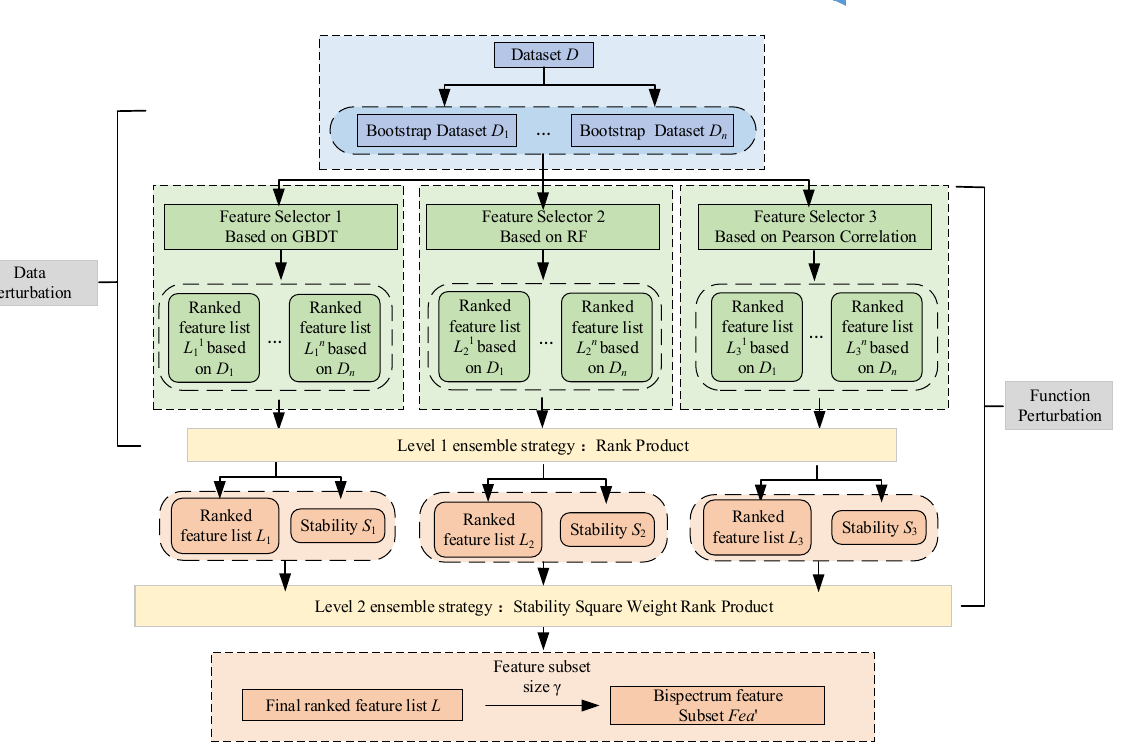
Figure 2. The framework of two-level EFS method.